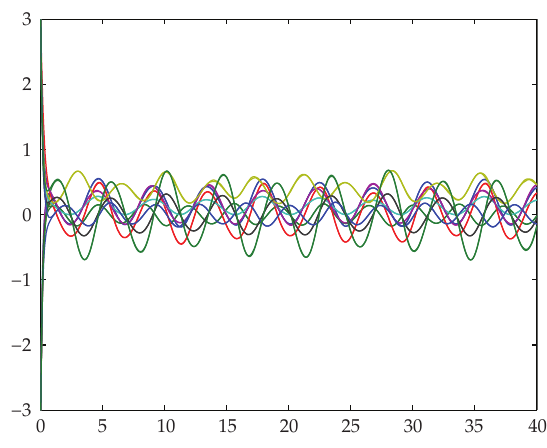
Figure 2: States of networks (cid:4) 5.1 (cid:5) with t ∈ (cid:8) 0 , 40 (cid:9)